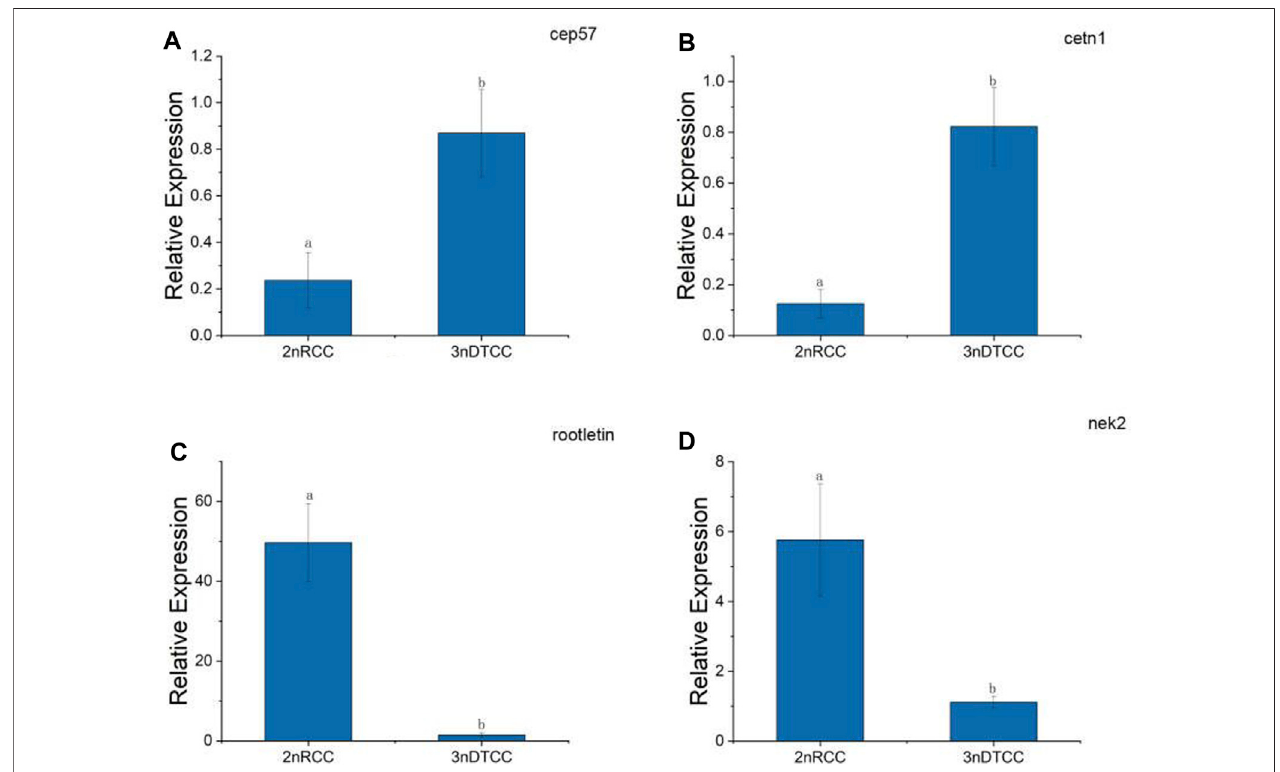
FIGURE 4 | Real-time PCR analysis for cep57 , cetn1 , rootletin , and nek2 in 2nRCC and 3nDTCC. (A) cep57 , centrosomal protein of 57 kDa; (B) cetn1, centrin 1; (C) rootletin, (D) nek2, NIMA-relatedkinase2.Thedifferentlowercaselettersineachpanelindicatesigni fi cantdifferences at p < 0.05(mean ± SDofrelativeexpression; n (cid:2) 9 for each group).